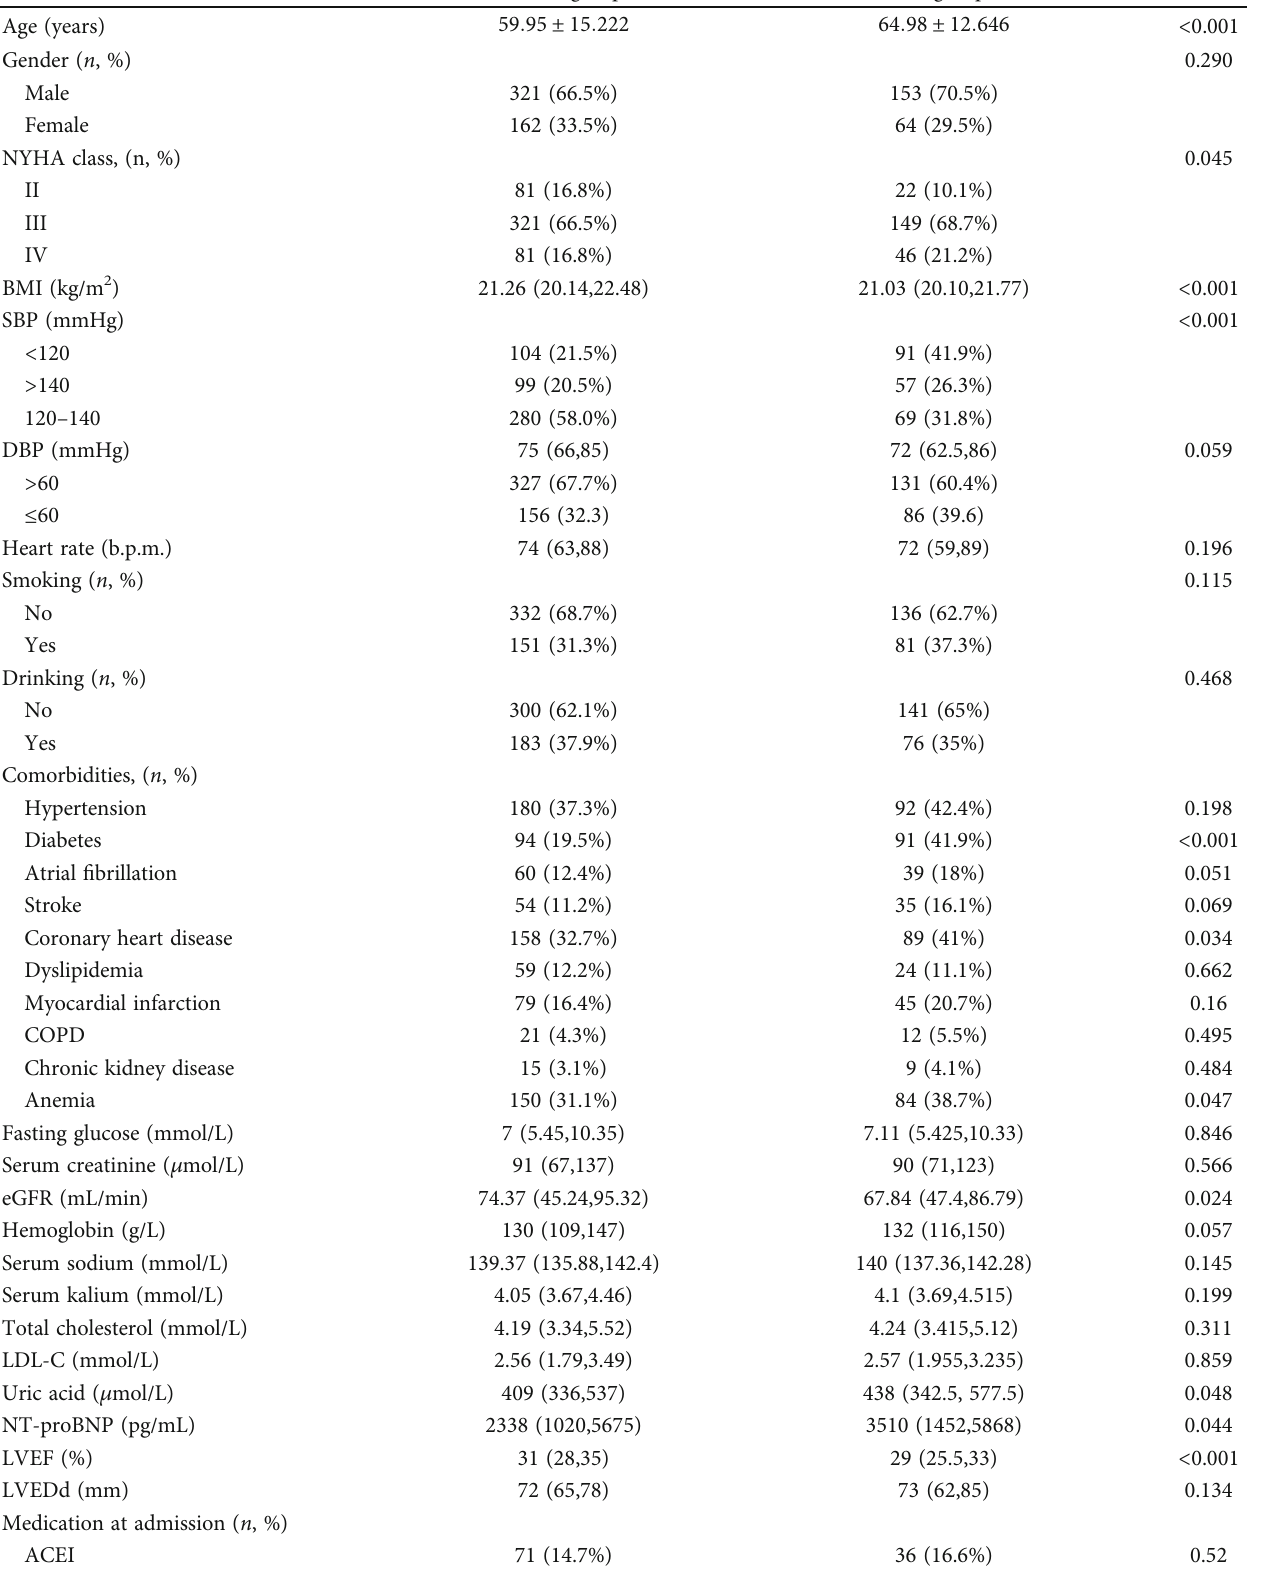
Table 1: Baseline characteristics of the nonreadmission group and readmission